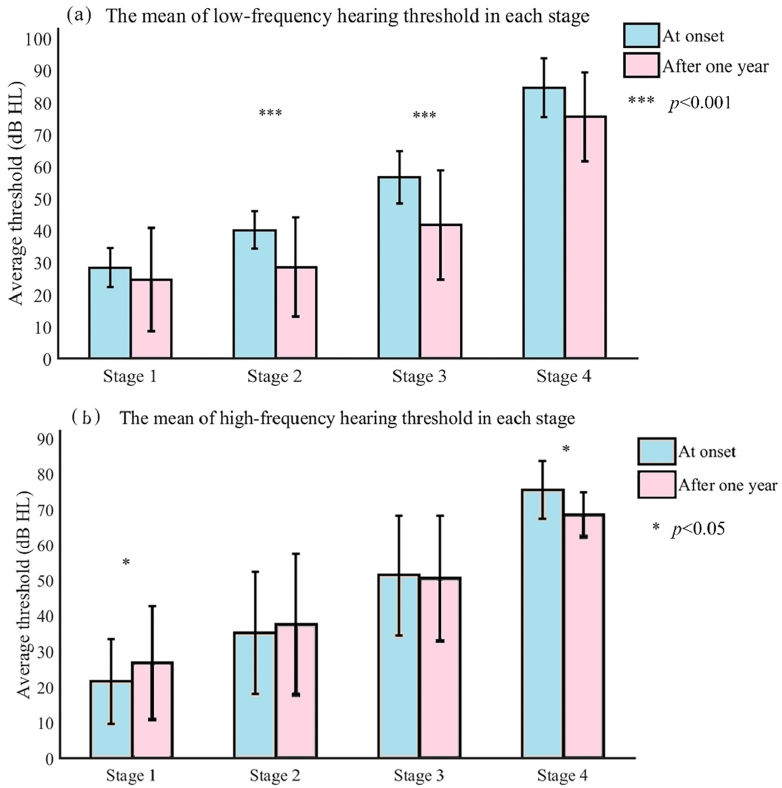
Figure 2. The mean low-frequency and high-frequency hearing thresholds at onset and after one year for each stage.